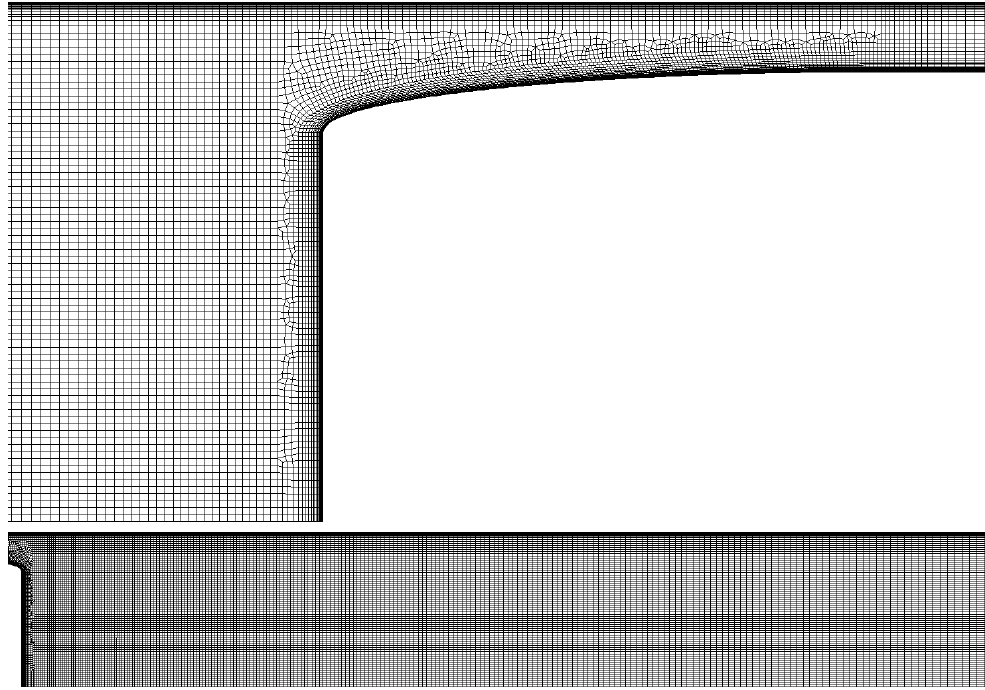
Figure 4. Captures for the mesh used in the compressor case and β = 0.75. Top figure is for the upstream domain, and bottom is for the